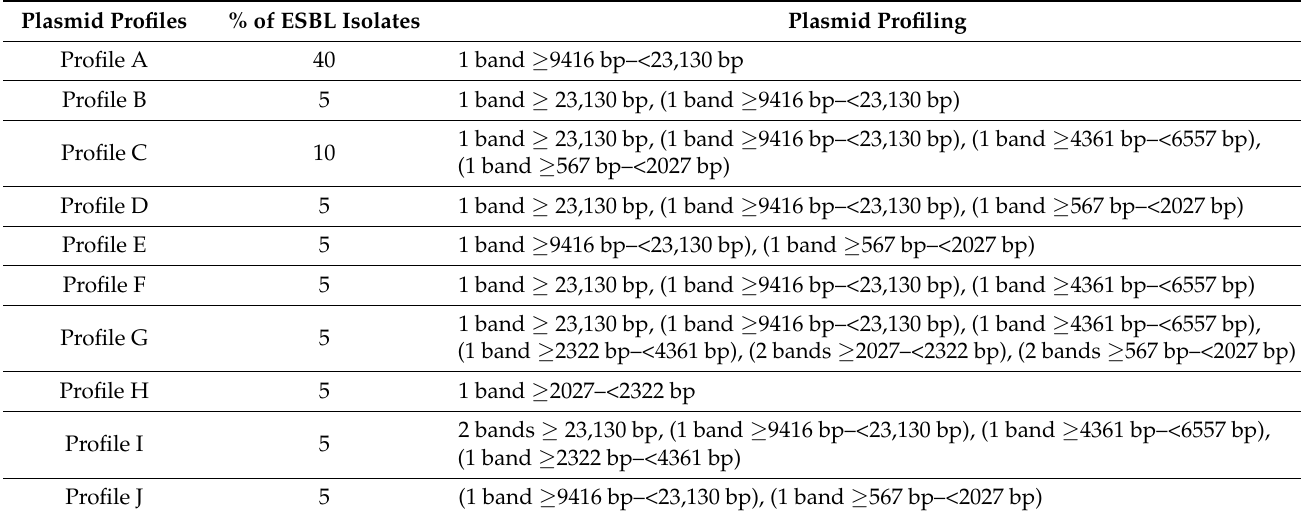
Table 4. Plasmid profiles found in ESBL-negative MDR- A. baumannii isolates.